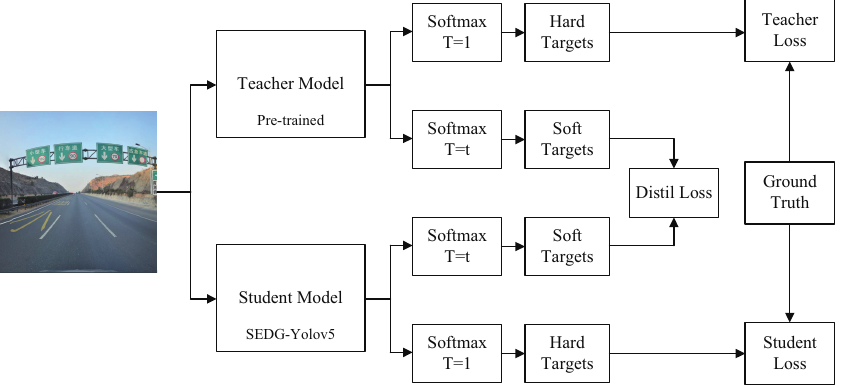
Figure 6. Response-based objectness scaled distillation framework.